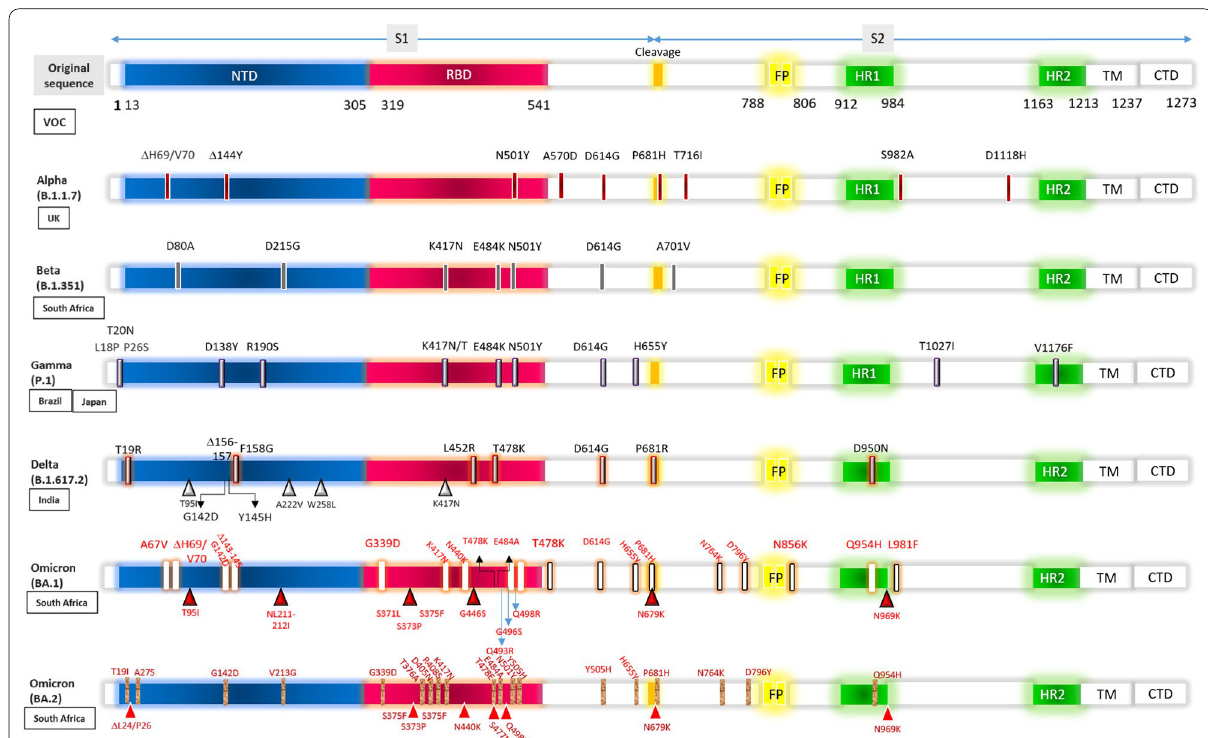
Fig. 3 SARS-CoV-2 variants of concern (VOC). The amino acid changes have been shown in all the VOC which have been compared with the genome sequence of the spike (S) protein of the original SARS-CoV-2 strain from Wuhan, China. NTD N-terminal domain, RBD receptor binding domain, FP fusion peptide domain, HR1 Heptad repeat 1, HR2 Heptad repeat 2, TM transmembrane domain, CTD C terminal